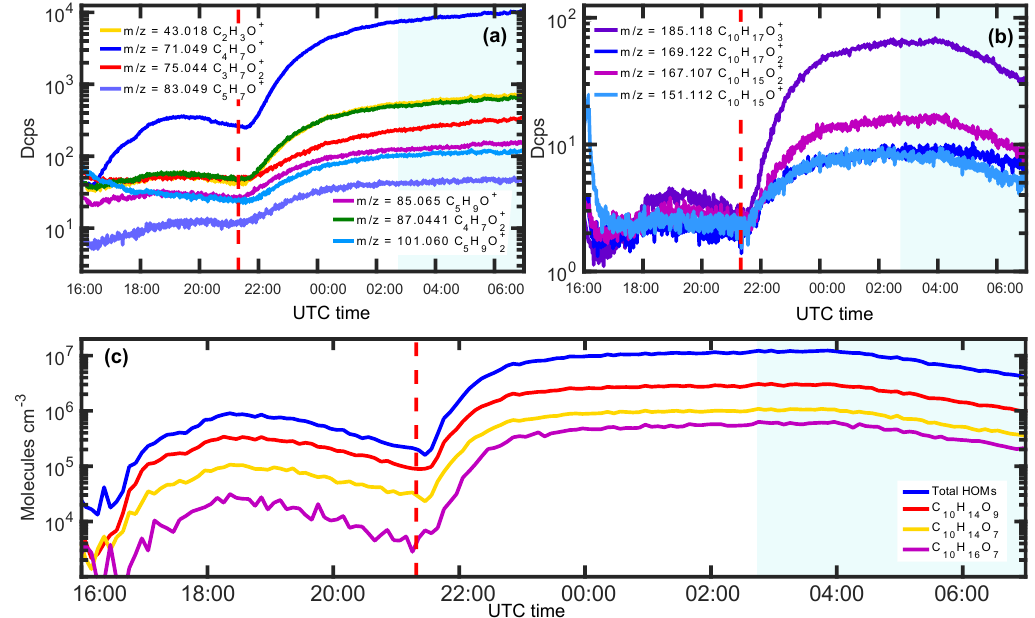
Figure 4. (a) Time series of selected pure isoprene oxidation products in 2016. (b) Time series of main monoterpene-analogue oxidation products which show a typical decrease towards the end due to a removal of the precursor with the cryotrap while the isoprene products are not affected. (c) Time series of total HOMs and the three major contributors (C 10 compounds) to the total signal. The red dashed line corresponds to the injection time of ozone and the blue shaded area to the times with the